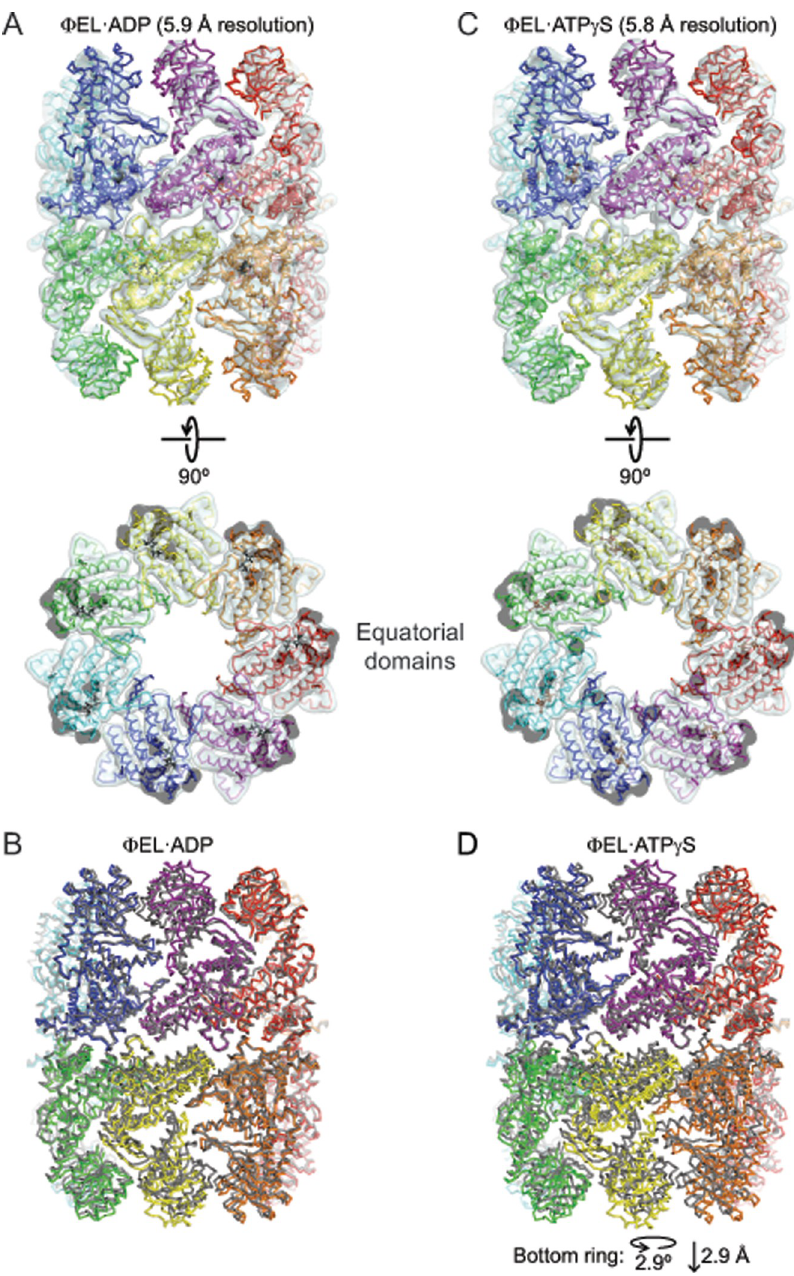
Fig 8. CryoEM structures of ɸ EL in complex with ADP or ATP γ S. (A) Superposition of the cryo-EM density map and the structural model of the ɸ EL•ADP complex. The pseudo-atomic model is shown as backbone trace, with the subunits colored individually. ADP is shown in stick representation. The cryo-EM density map is shown as an isocontour surface at 4.5 σ . Two perpendicular views are shown. In the bottom view, only the equatorial domain section is shown to demonstrate the quality of the fit. (B) Superposition of the ɸ EL•ADP complex with apo- ɸ EL, showing the unaltered ring-ring interface. Backbone traces are shown. The ɸ EL•ADP complex is shown in rainbow colors, and apo- ɸ EL in grey. (C) Superposition of the cryo-EM density map and the structural model of the ɸ EL•ATP γ S complex. The representation is the same as in panel A. (D) Superposition of the ɸ EL•ATP γ S complex with apo- ɸ EL, showing the changes at the ring-ring interface. Backbone traces are shown. The ɸ EL•ATP γ S complex is shown in rainbow colors, and apo- ɸ EL in grey.